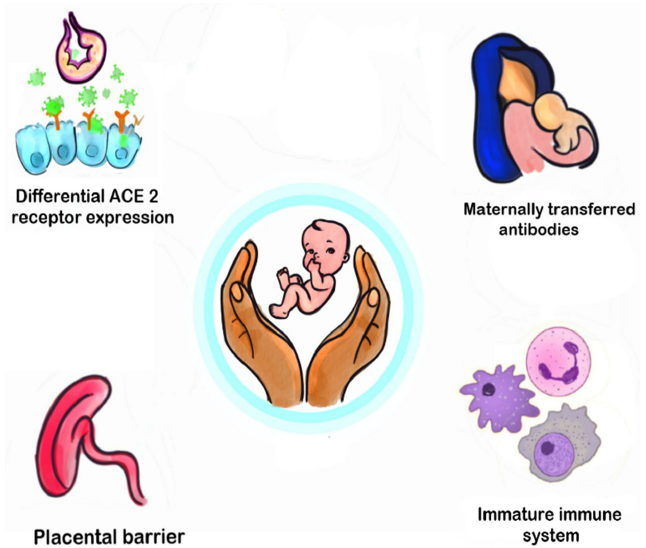
Figure 2. Key mechanisms by which young children resist SARS-CoV-2 infection. ACE, angiotensin- converting enzyme.